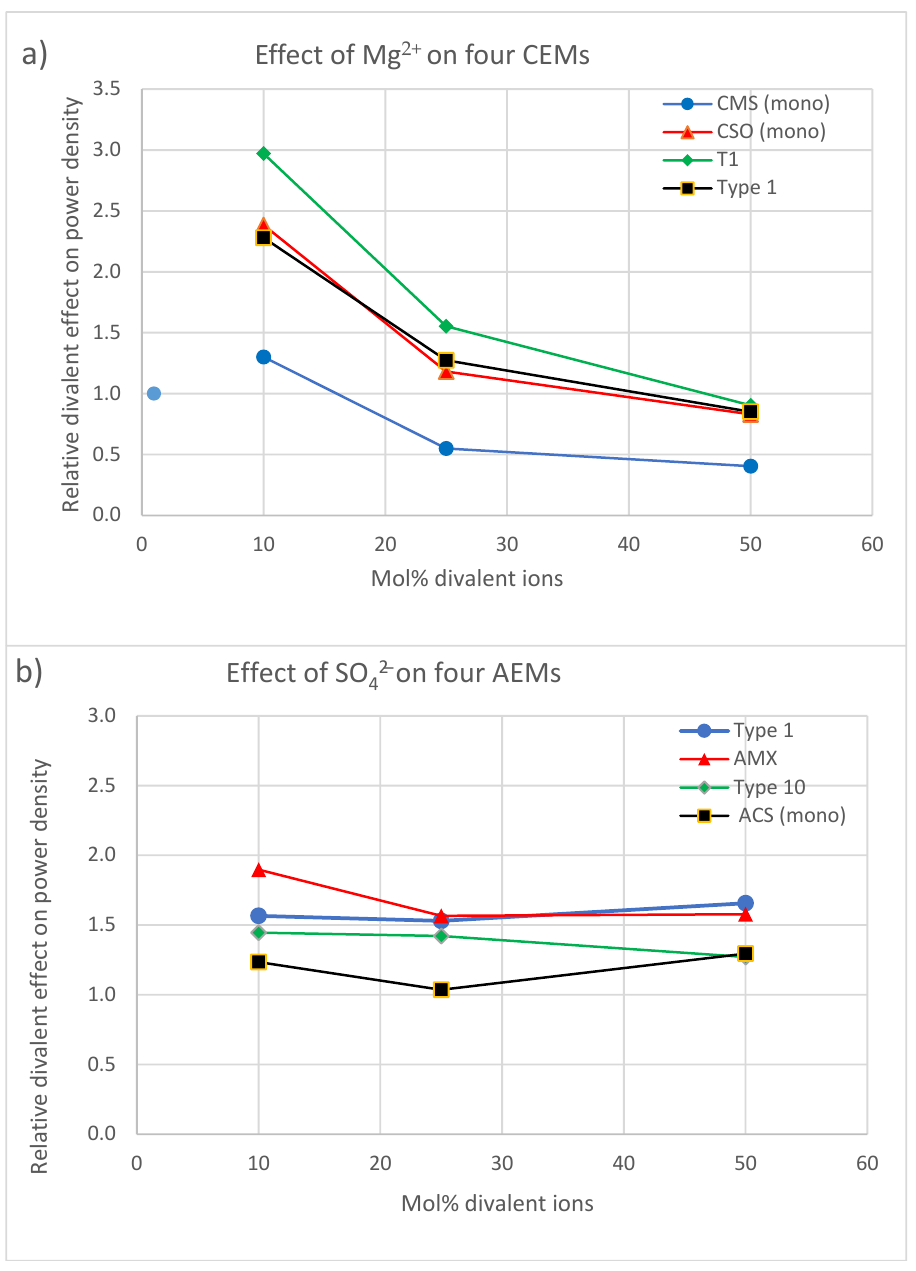
Figure 11. Relative divalent effect on power density for four CEMs ( a ) and four AEMs ( b ).